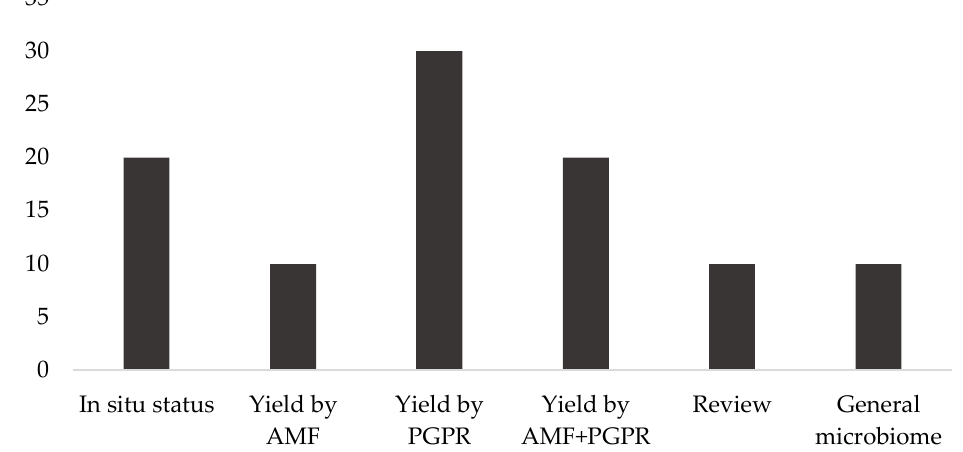
Figure 3. Subjects covered in the selected papers, in percentage, addressing the studies on microbiology of olive trees in Brazil, between brackets. In situ status [3], Yield by AMF [64], Yield by PGPR [65,66,69], Yield by AMF + PGPR [67,68], Review [5], General microbiome [70].